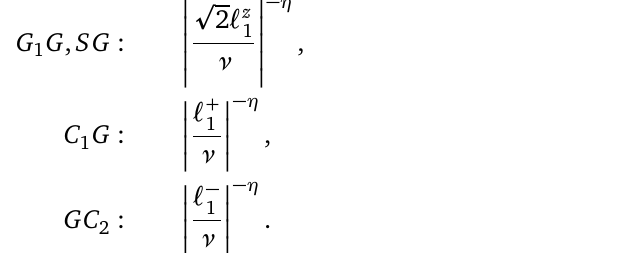
Figure 11: A convenient routing choice for the plus and minus components of (cid:96) diagram